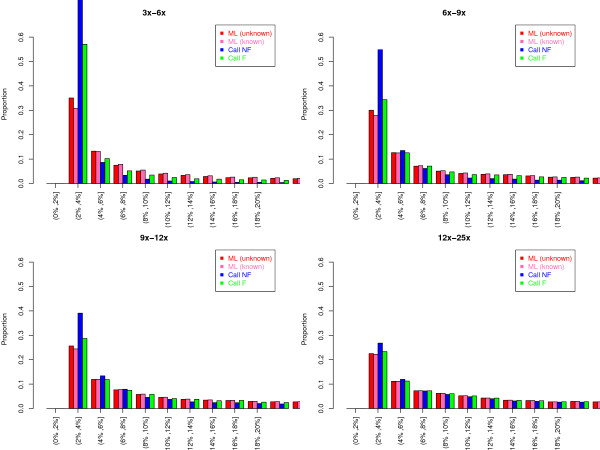
Distribution of the minor allele frequency estimated from the exomes of 200 sequenced individuals. For each site, the minor allele frequency was estimated using four different methods: (1) the ML method with unknown minor allele, (2) the ML method with a known or fixed minor allele, (3) calling genotypes without filtering (Call NF), and (4) calling genotypes with filtering (Call F). Each site is classified into bins based on the depth of coverage. Furthermore, in each histogram, sites with estimated MAF less than 2% are not considered. For the number of SNPs that were used for this analysis, see Table 1.